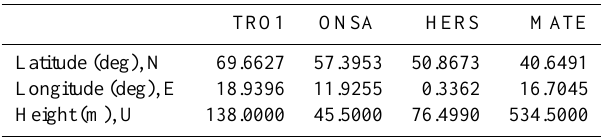
Table 1. Coordinates of the IGS stations considered for analyses in this